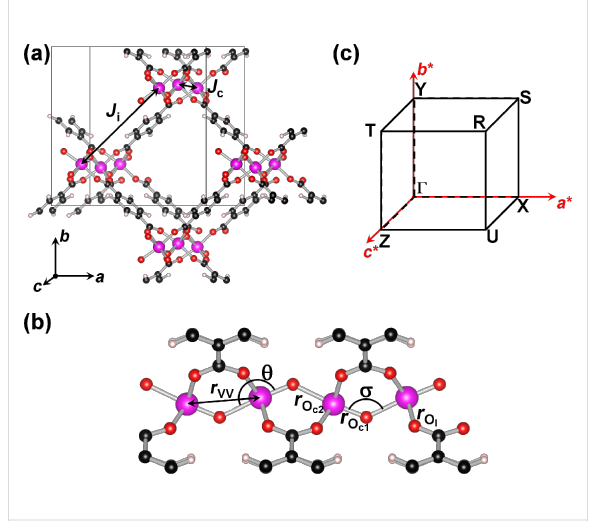
Figure 1: (a) Ball-and-stick representation of the MIL-47(V) MOF. Pink, red, black, and white spheres indicate V, O, C and H positions, respectively. The grey box indicates the unit cell used. The intra- and inter-chain couplings J c and J i (cf. section “Stability and magnetic coupling”) are indicated. (b) Representation of the Brillouin zone of the unit cell, showing the high symmetry k -points. (c) Ball-and-stick repre- sentation of a single vanadium oxide chain, indicating the superex- change angle σ , the octahedral backbone angle θ , the inter-V-dis- tance r VV , and the V–O bond lengths and along the chain, and to the